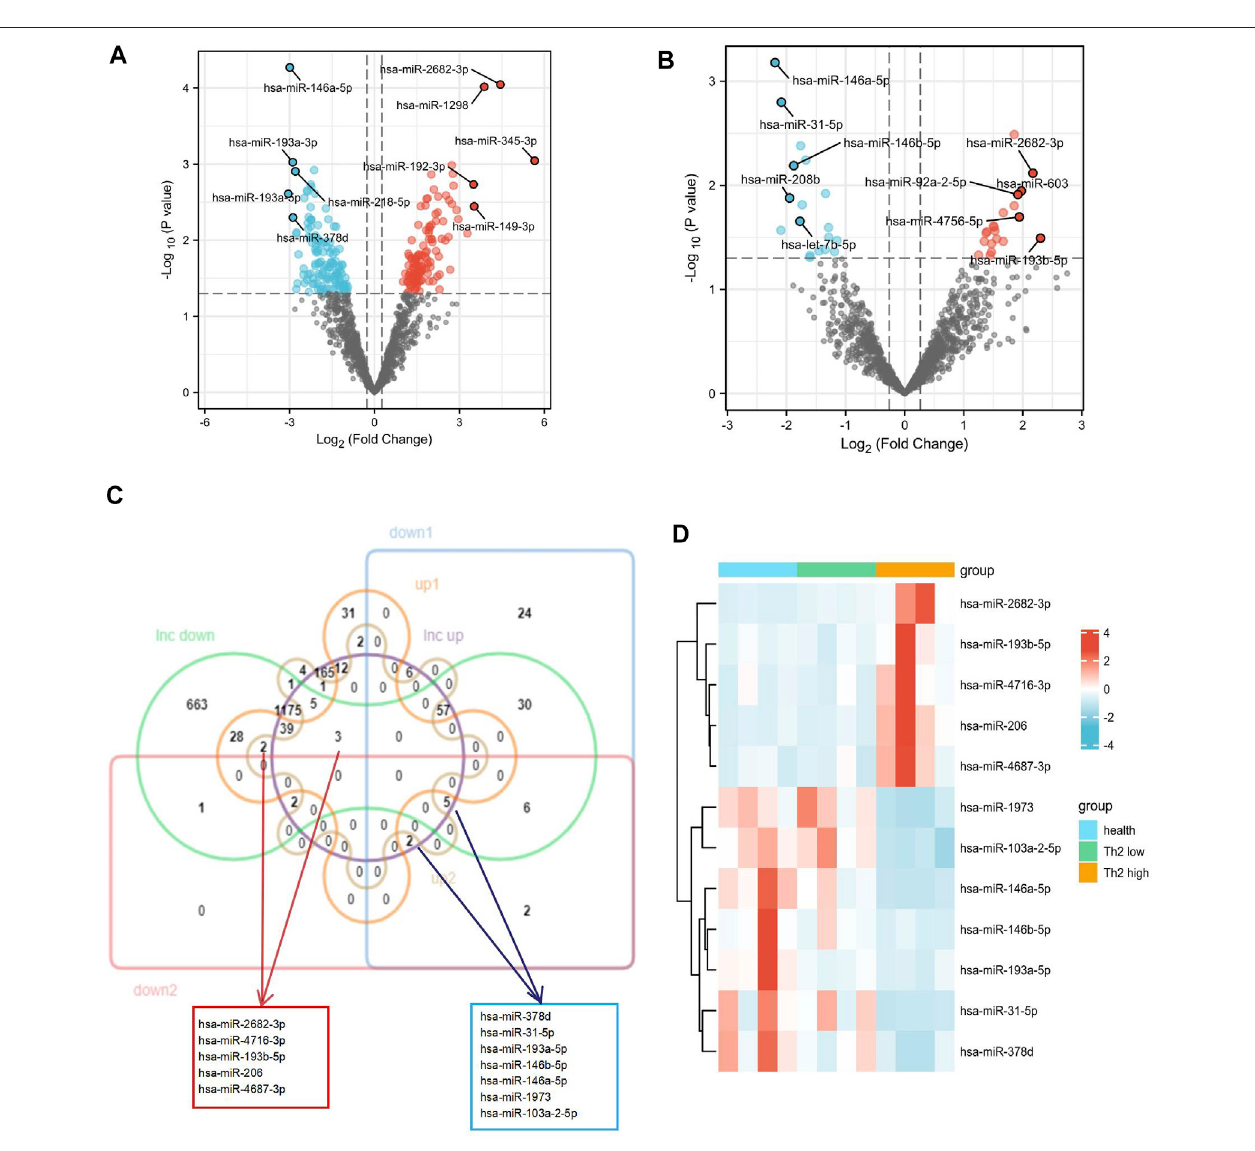
FIGURE 5 | Identi fi cation of the DEmiRNAs related to Th2 high asthma. (A – B) Volcano plot of the differentially expressed miRNAs between Th2 high asthma and healthycontrolgroupsandbetweenTh2highasthmaandTh2lowasthmagroups.Theupregulatedanddownregulatedgeneswithtop fi ve ｜ logFC ｜ weremarked. (C) Venn diagram of upregulated and downregulated predicted target DEmiRNAs. (D) The heat map of expression of the 12 target miRNAs.